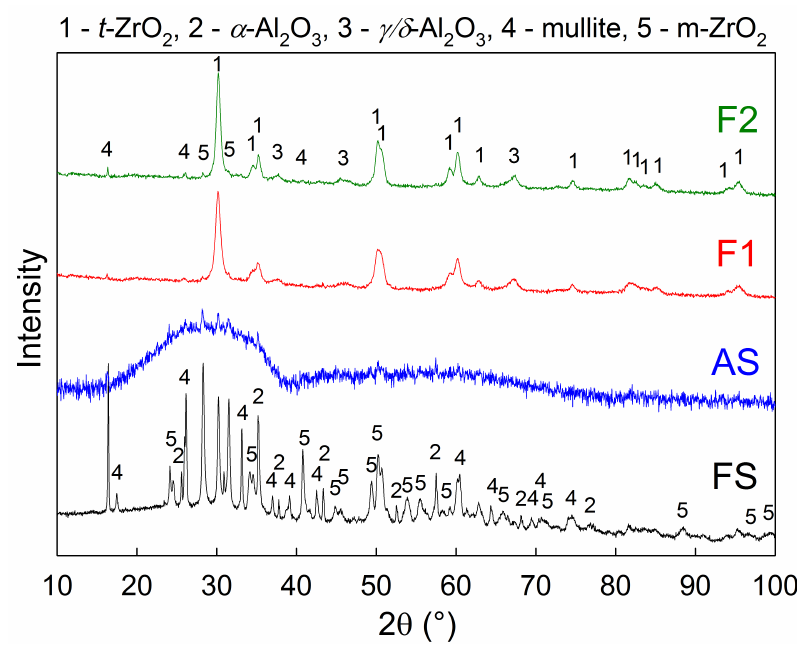
Figure 9. X-ray diffraction patterns of the feedstock (FS), as sprayed coating (AS), and furnace heat treated samples (F1 and F2).